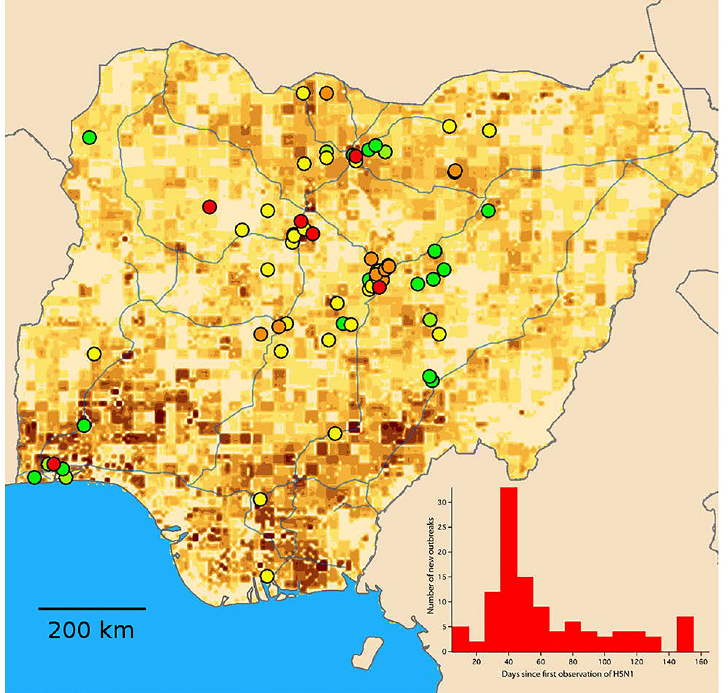
Fig 5. Fig 5 shows a depiction of the 2006 Nigerian avian H5N1 influenza outbreak in 2006. The data shown are structurally similar to that the data acquired from the EMPRES-i system developed by the UN-FAO. Inset is a histogram of the outbreak frequency, showing a peak at approximately 40 days post the initial identification of the disease in Kaduna, Nigeria.